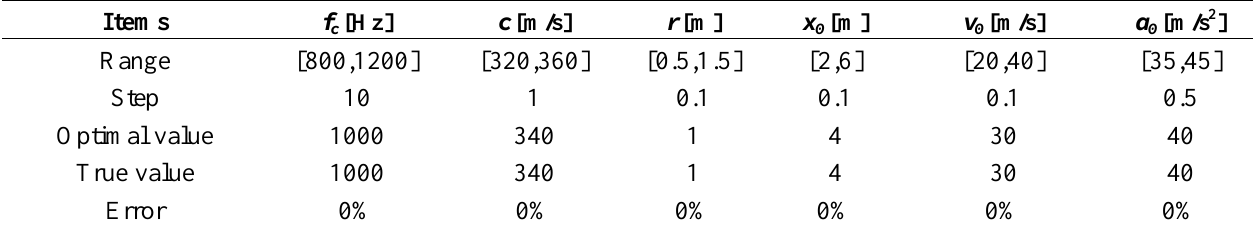
Table 1. Kinematic model parameters subset and the optimal kinematic model parameters of the simulated